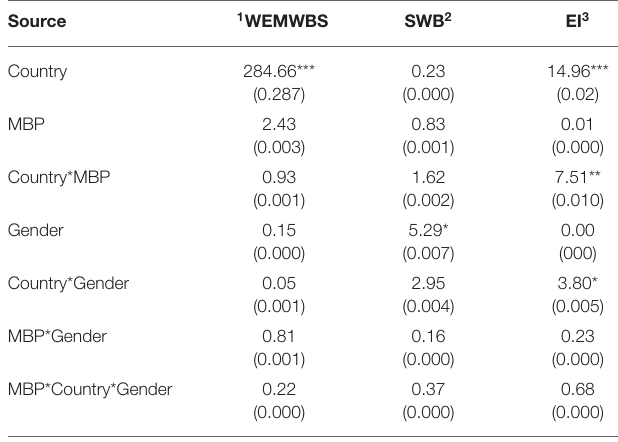
TABLE 3 | Analysis of variance results for outcome